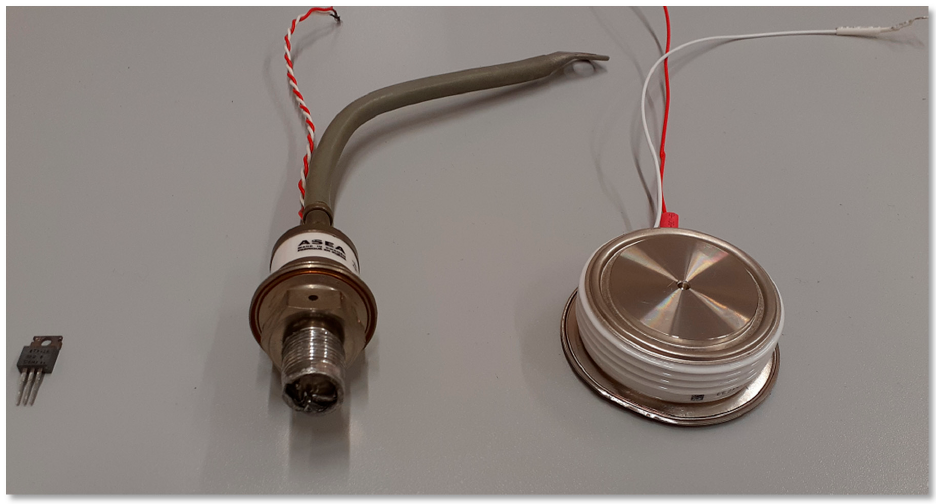
Figure 1. Example of thyristors in plastic, stud-mount and press-pack